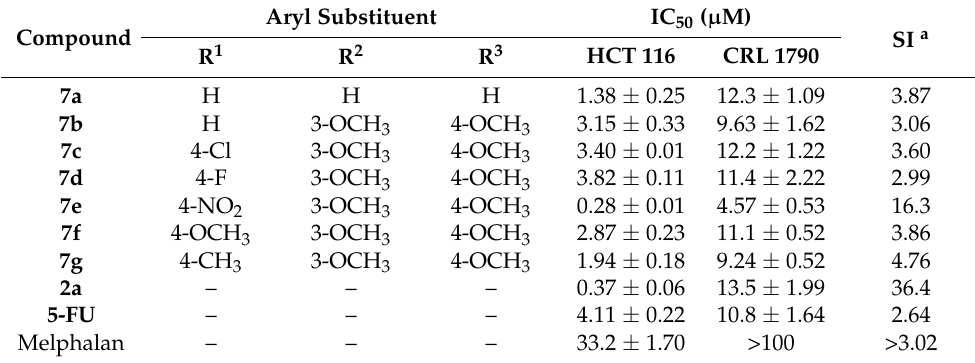
Table 4. Evaluation of 2a and 7a–g against HCT 116 and CRL 1790 cells.